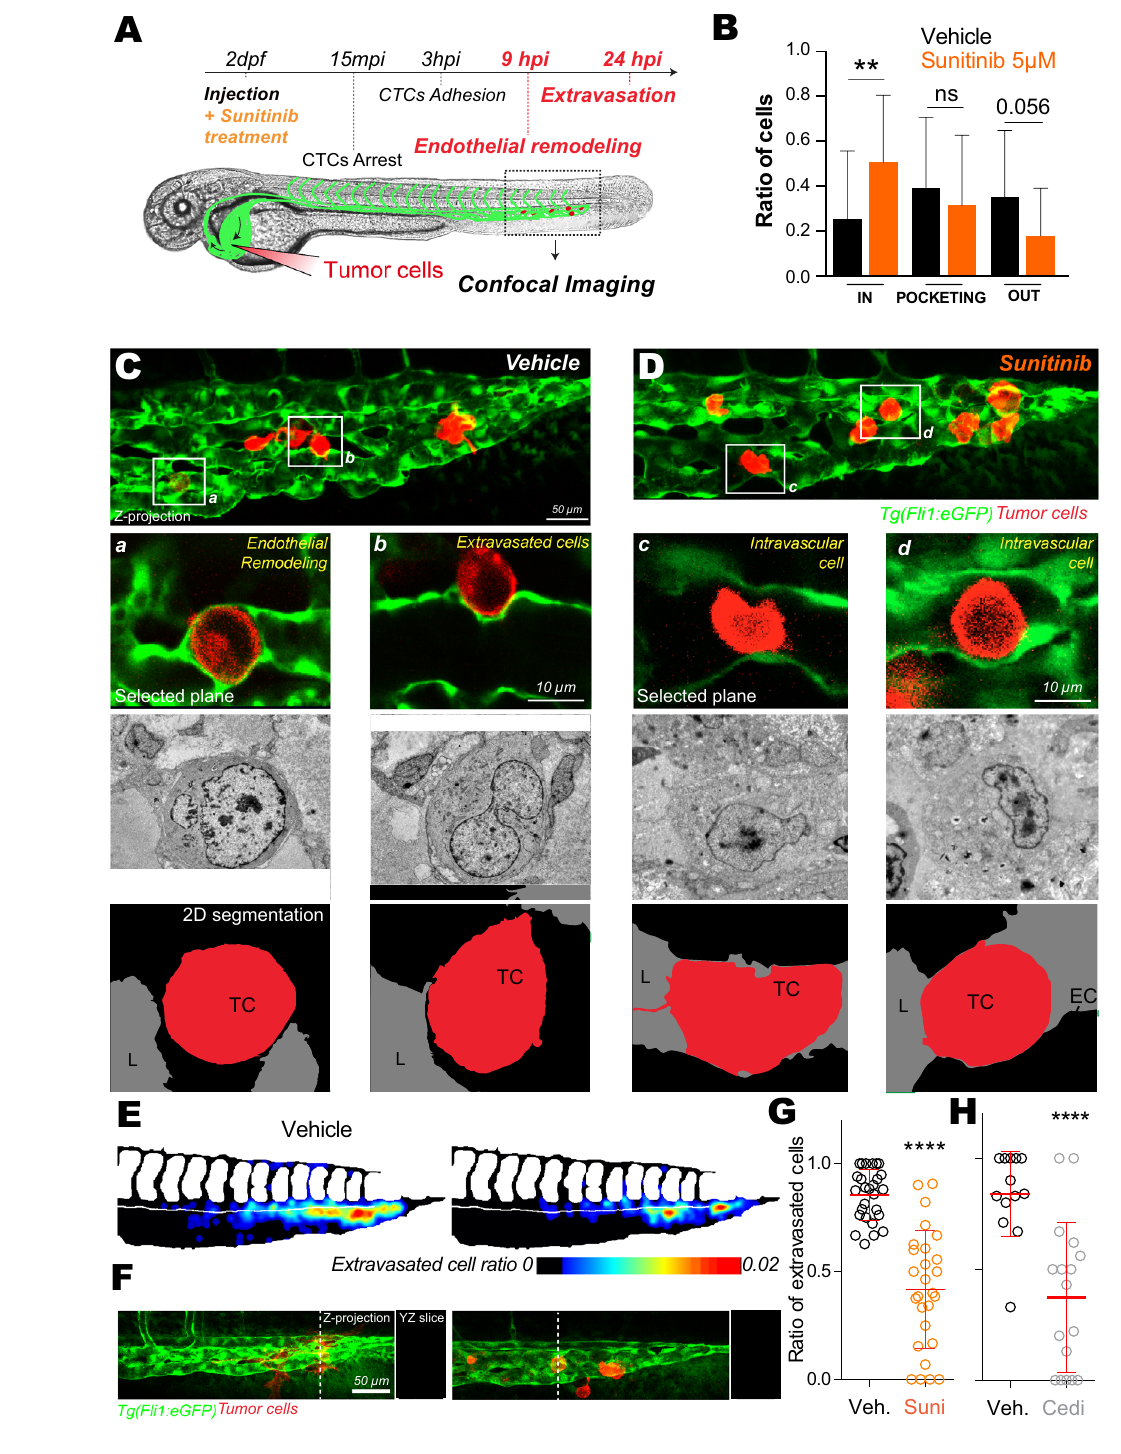
Figure 4. Inhibition of VEGFRs with sunitinib impacts extravasation by endothelial remodeling. (A) Experimental setup used: zebrafish are imaged at 9 hpi & 24 hpi. (B) Quantification of intravascular, remodeling and extravasated cells 9 hpi. N cells: vehicle = 134, sunitinib = 155. N embryos: vehicle = 23, sunitinib = 25, Kruskal–Wallis test followed by Dunn’s multiple Comparison test. (C,D) Representative image of the caudal plexus by confocal intravital imaging (upper panel), corresponding correlative light and electron microscopy imaging (middle panel) and reconstructed segmented images (lower panel). In vehicle treated embryos, tumor cells of interest are a and b (white squares on (C) ). In sunitinib treated embryos, tumor cells of interest are c and d (white squares on (D) ). TC tumor cell, EC endothelial cell, L lumen. (E) The heatmaps show the quantification and location of extravascular CTCs at 24 hpi in the caudal plexus treated with vehicle or 2 µM of sunitinib. (F) Representative images and orthoslice at 24 hpi. (G) Quantification of extravasated cells ratio at 24 hpi treated with vehicle or 2 µM of sunitinib. N cells: vehicle = 588, sunitinib = 441. N embryos: vehicle = 27, sunitinib = 27, Mann Whitney test. (H) Quantification of extravasated cells ratio at 24 hpi treated with vehicle or 0.1 µM of cediranib. N cells: vehicle = 134, cediranib = 143. N embryos: vehicle = 13, cediranib = 17, Mann Whitney